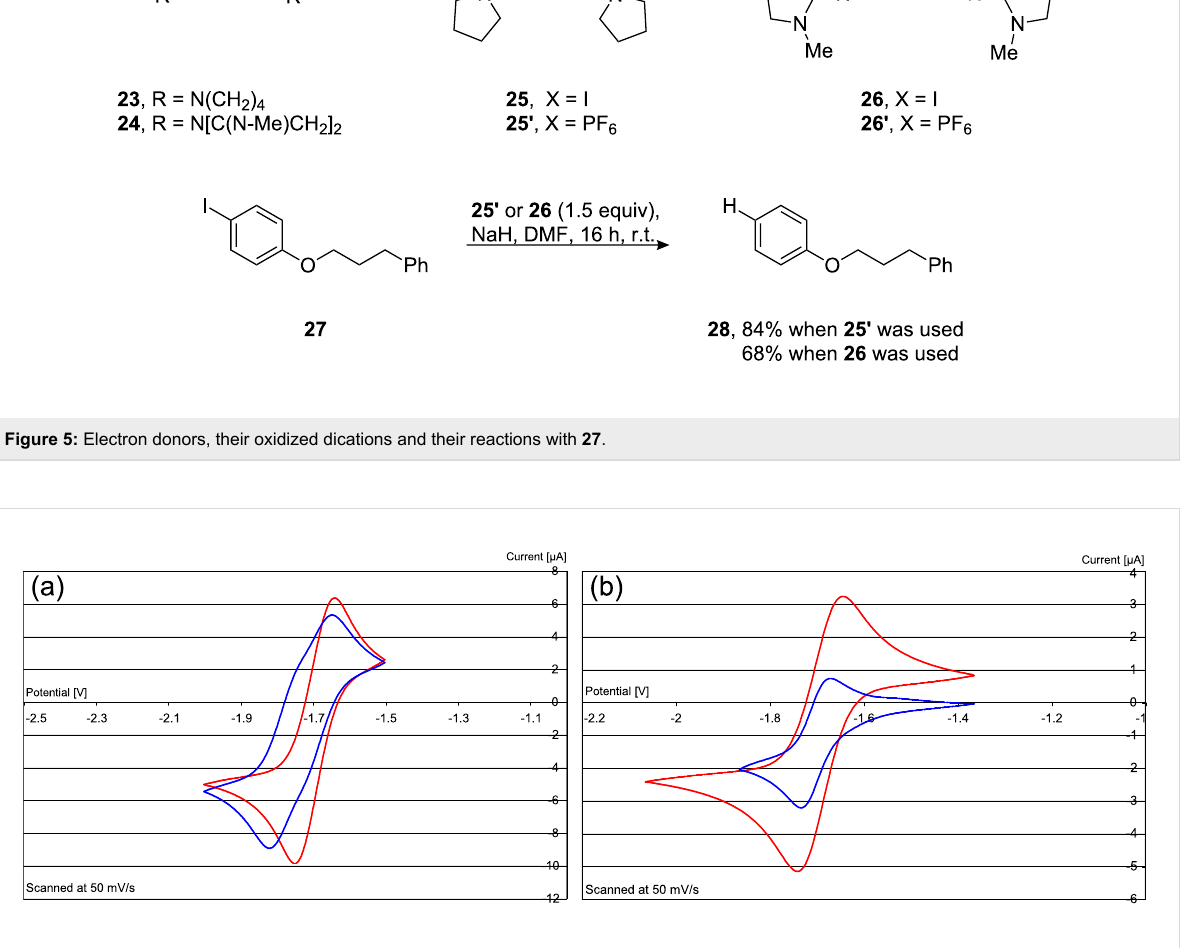
Figure 6: Cyclic voltammograms vs Fc/Fc + (a) of 17 ′ ↔ 8 (red) and 21 ′ ↔ 23 (blue) and (b) of 17 ′ ↔ 8 (red) and 22 ′ ↔ 24 (blue) (at half the concn used for 17 ′ ).